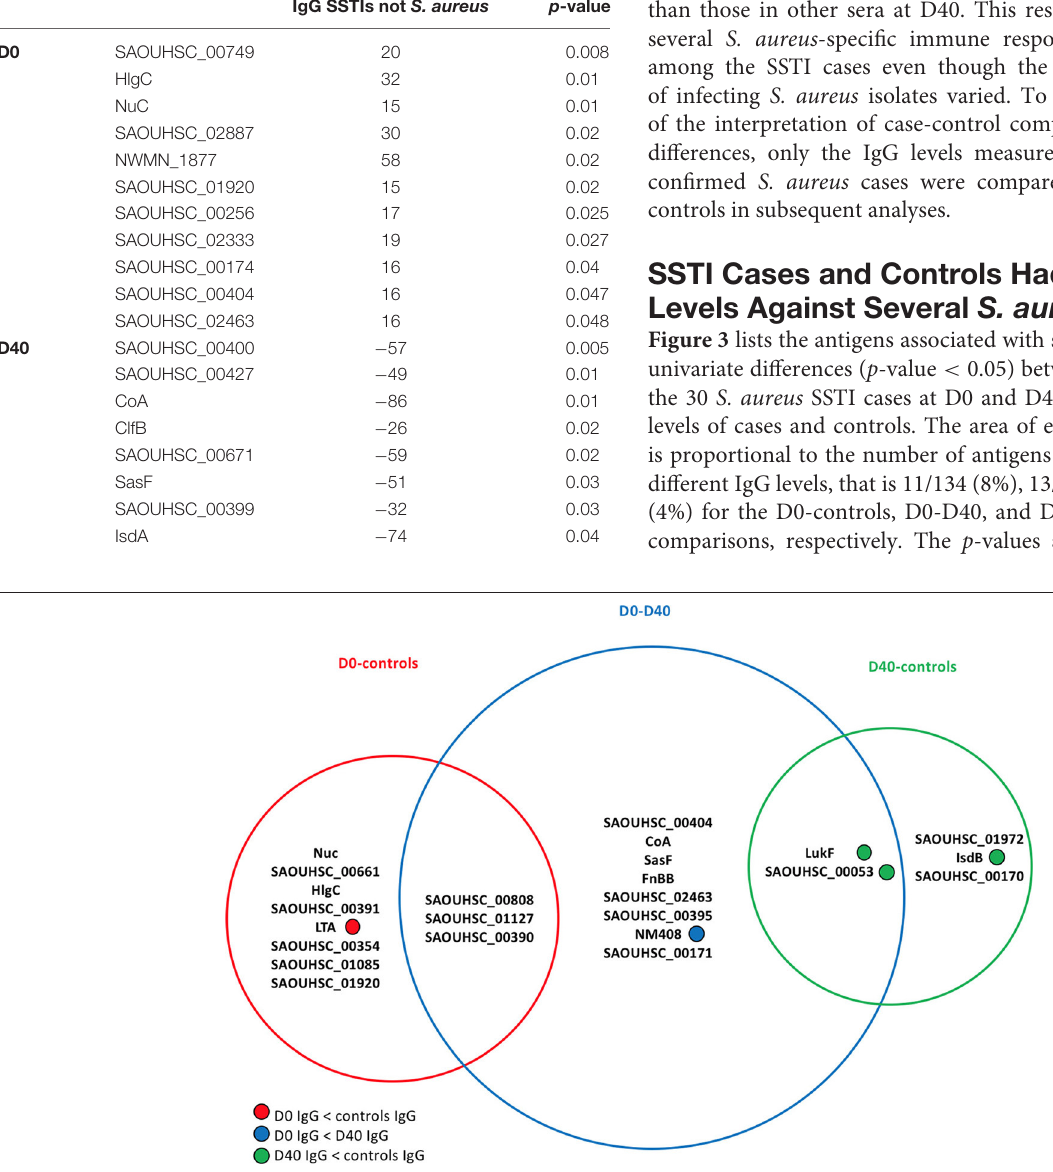
FIGURE 3 | Venn diagram showing the antigens having statistically significant differences ( p -value < 0.05) in analyses comparing the frequency distributions of the IgG levels measured in the 30 culture-confirmed S. aureus SSTI subject serum samples at D0 and D40 or between the IgG levels measured in the 30 SSTI serum samples and the samples from controls. The area of each circle is proportional to the number of antigens carrying significantly different IgG levels measured across subjects in each pair-wise comparison. A total of 11/134 (8%), 13/134 (10%), and 5/134 (4%) antigens carried different IgG levels for the D0-controls, D0-D40, and D40-controls pair-wise comparisons, respectively. For information about the antigens included here, (see the Supplementary Materials , Table S1 ).